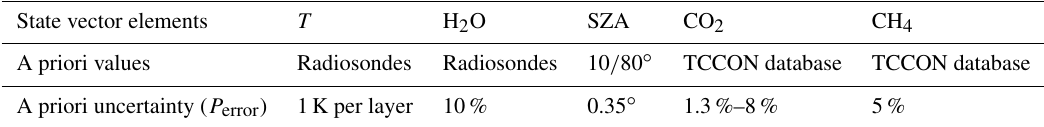
Table 1. State vector parameters. State vector elements